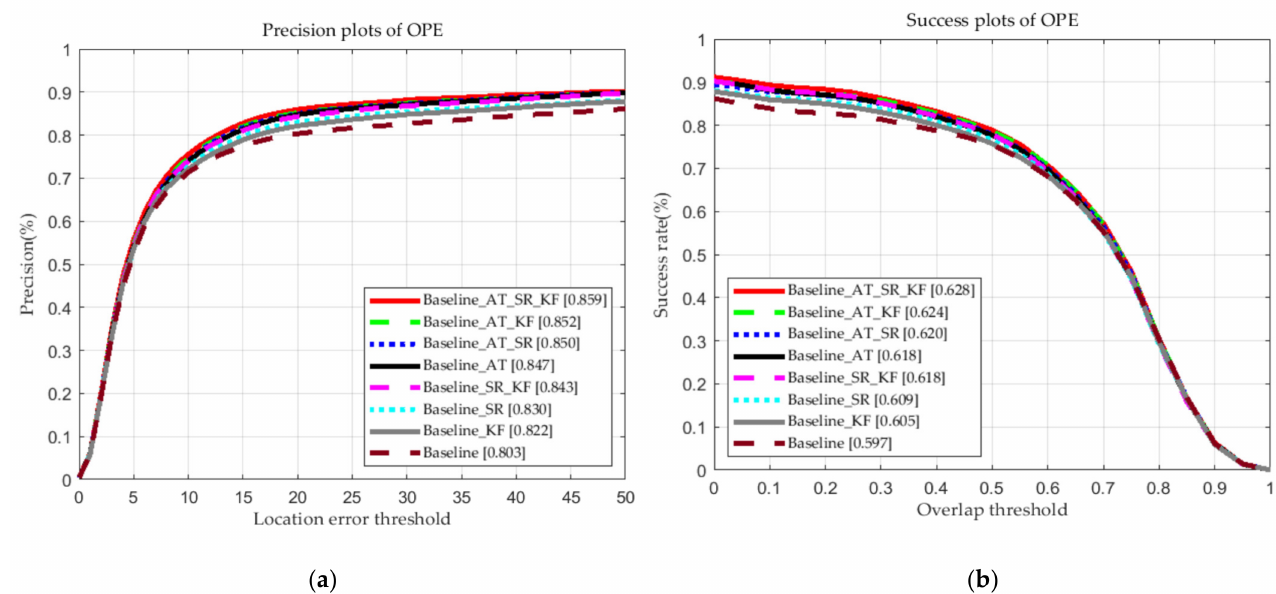
Figure 7. The performance of different components and their combinations in Ad_SASTCA, evaluated on OTB-2013. The trackers in figures ( a ) and ( b ) are sorted according to precision and AUCs, respectively.